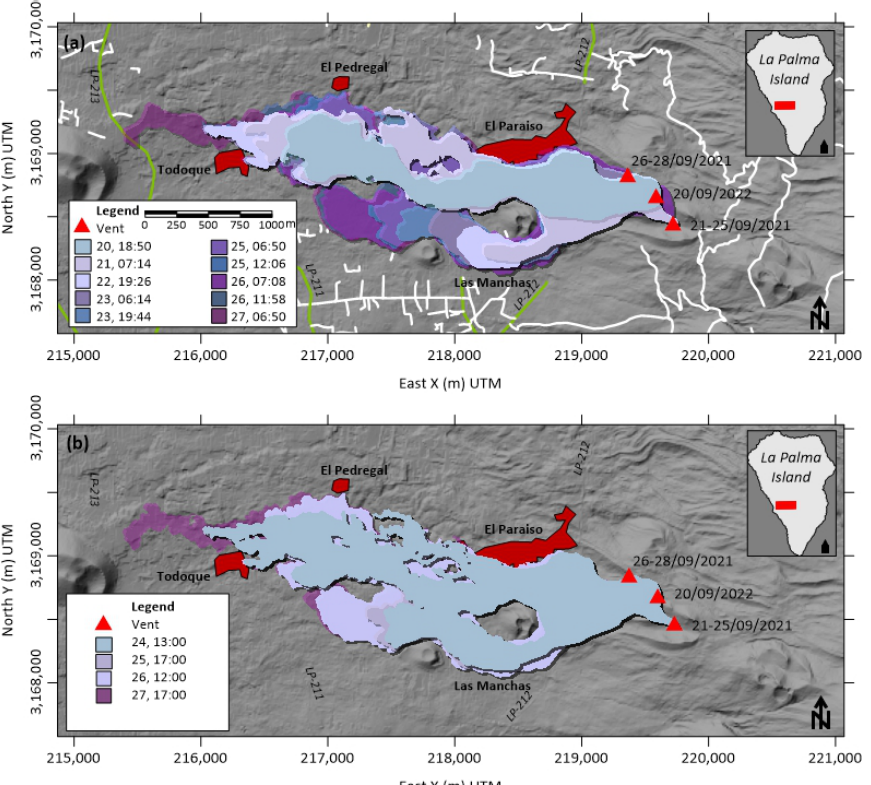
Figure 2. Extent and location of the lava flow progress for the indicated dates (Table 1), from 19 September 2021 (beginning of the eruption) until 27 September 2021 (time span considered in this study), obtained from ( a ) high-resolution satellite imagery ([60]) and ( b ) from the orthophoto interpretation of the drone flights from El Cabildo Insular de La Palma. The legend in both figures shows the day in September and the time (dd, hh:mm) of the represented extent of the lava. The vents are marked according to the time of lava emissions that were active according to the observations (IGN). Some toponyms of the affected villages (red zones) and roads (main in green and secondary in white) are included for the geographical location of the lava flow. The shaded relief, the background in both images, was derived from the 6 m pixel DEM obtained by rescaling the original one at 2 m per pixel (source: IGN), UTM projection, datum Red Geodesica de Canarias, and ellipsoid GRS 1980/ IUGG 1980. In the upper right image box, the red rectangle marks the study area on the island of La Palma.